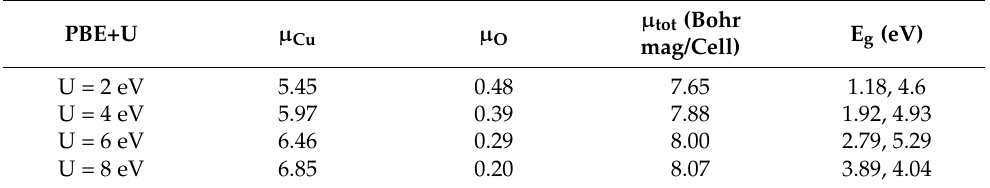
Table 3. Hubbard U parameter values for Cu (d) and O (p) orbitals, energy gap value, and mag- netic moments, calculated by the DFT/PBE+U methodology in a spin-polarized case. PBE+U μ Cu μ O μ tot (Bohr mag/Cell) E g (eV) U = 2 eV 5.45 0.48 7.65 1.18, 4.6 U = 4 eV 5.97 0.39 1.92, 4.93 U = 6 eV 6.46